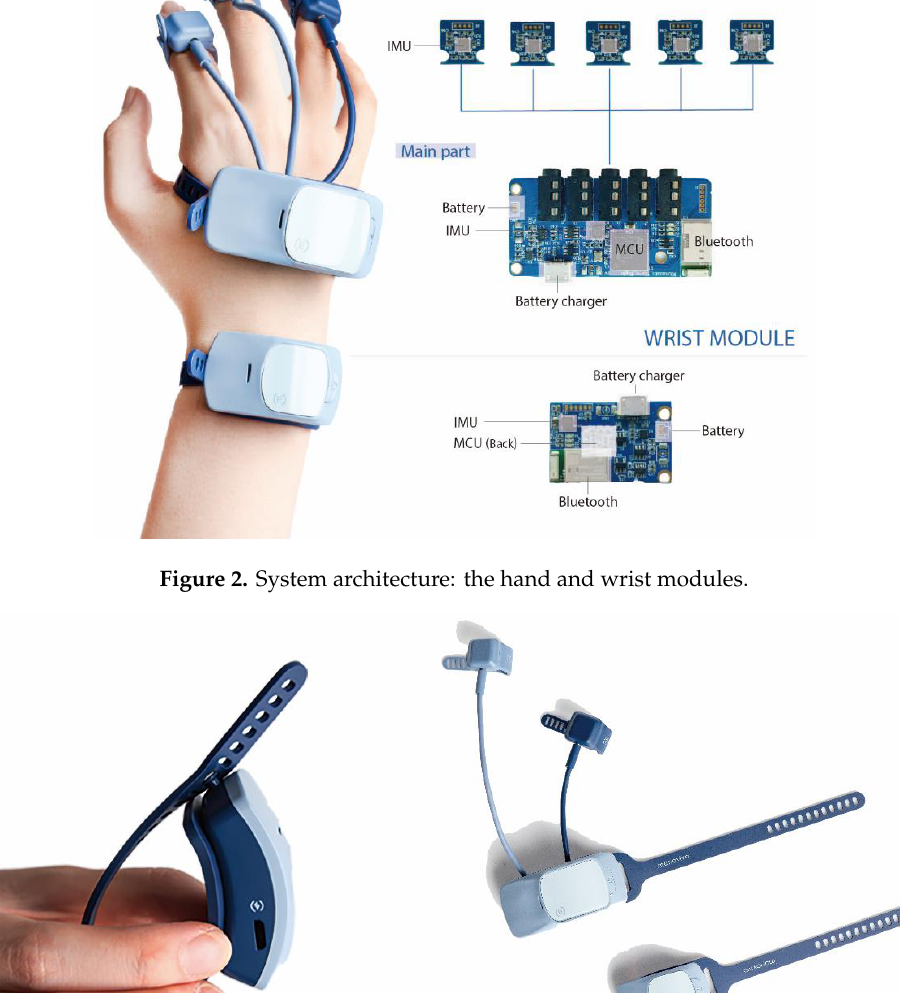
Figure 2. System architecture: the hand and wrist modules.